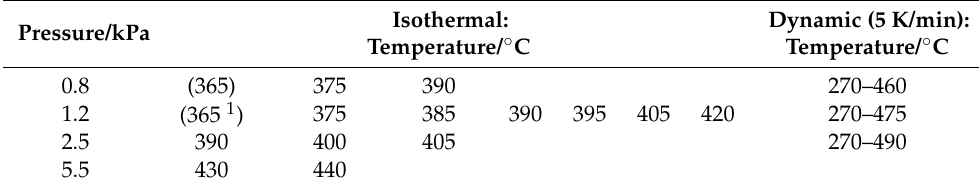
Table 1. Overview of the TGA measurements. Isothermal values in brackets have been measured, but they were not used for the fitting